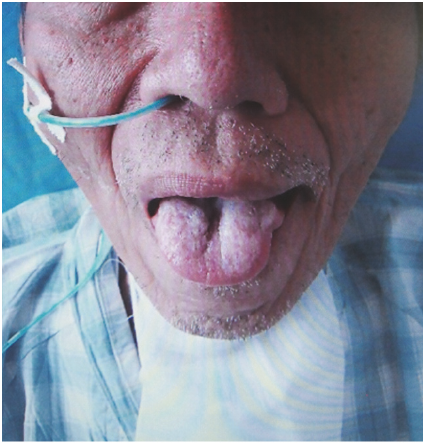
Figure 1: Atrophy and fasciculation of the tongue at the time of diagnosis of spinal and bulbar muscular atrophy